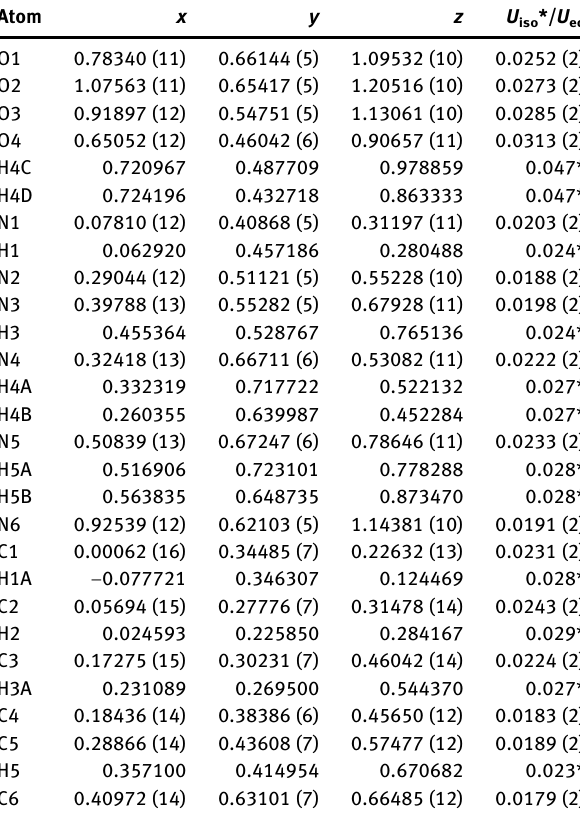
Table  : Fractional atomic coordinates and isotropic or equivalent isotropic displacement parameters (Å 